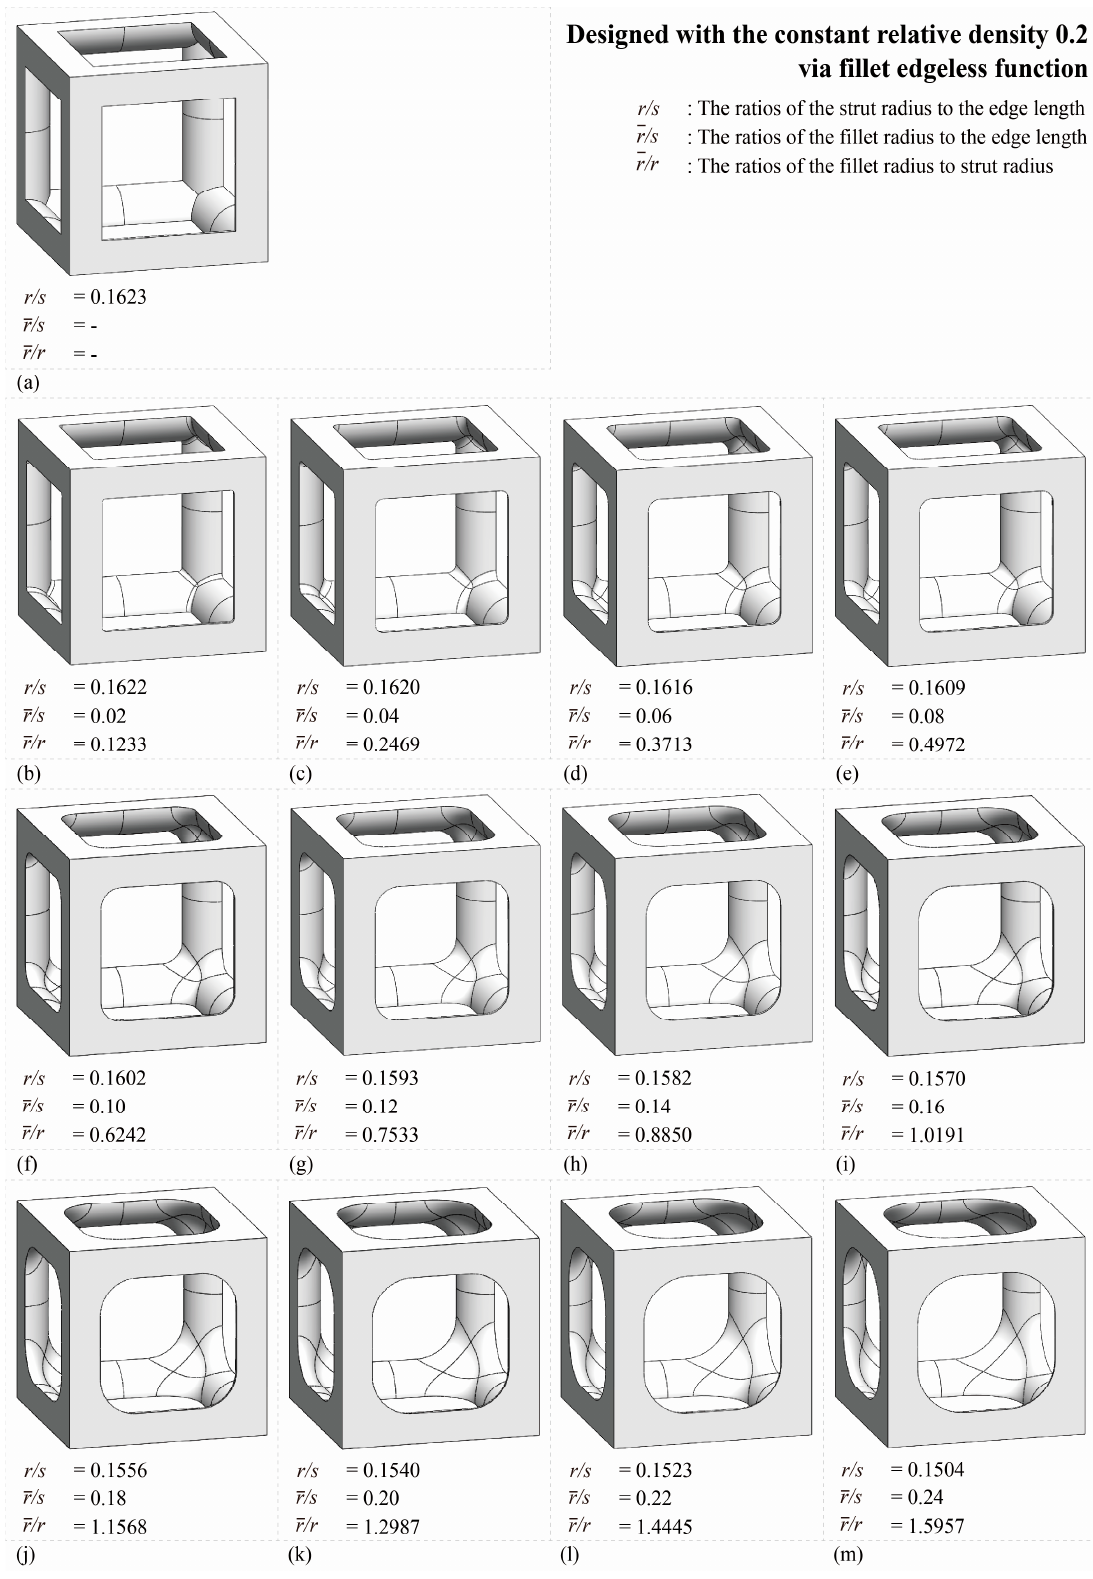
Figure 8. Various morphologies of fillet edgeless simple cubic unit cells with a relative density of 0.2: ( a ) conventional simple cubic unit cell; ( b – m ) fillet edgeless simple cubic unit cells.